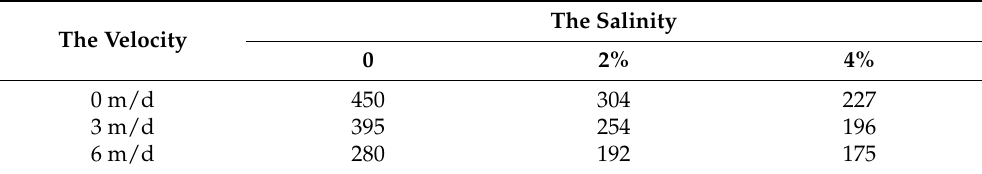
Table 5. The values of R u when freezing for 48 h (unit: mm). The Velocity